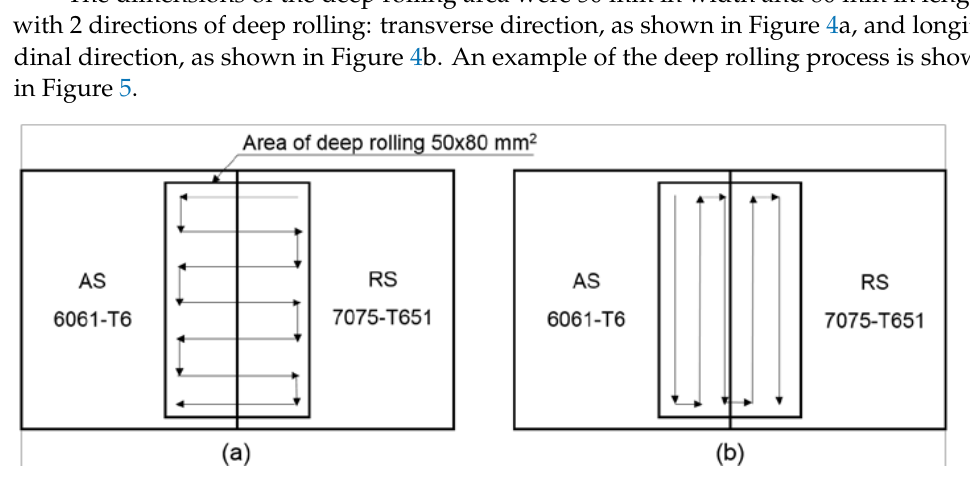
Figure 4. Deep rolling direction: ( a ) transverse direction and ( b ) longitudinal direction.